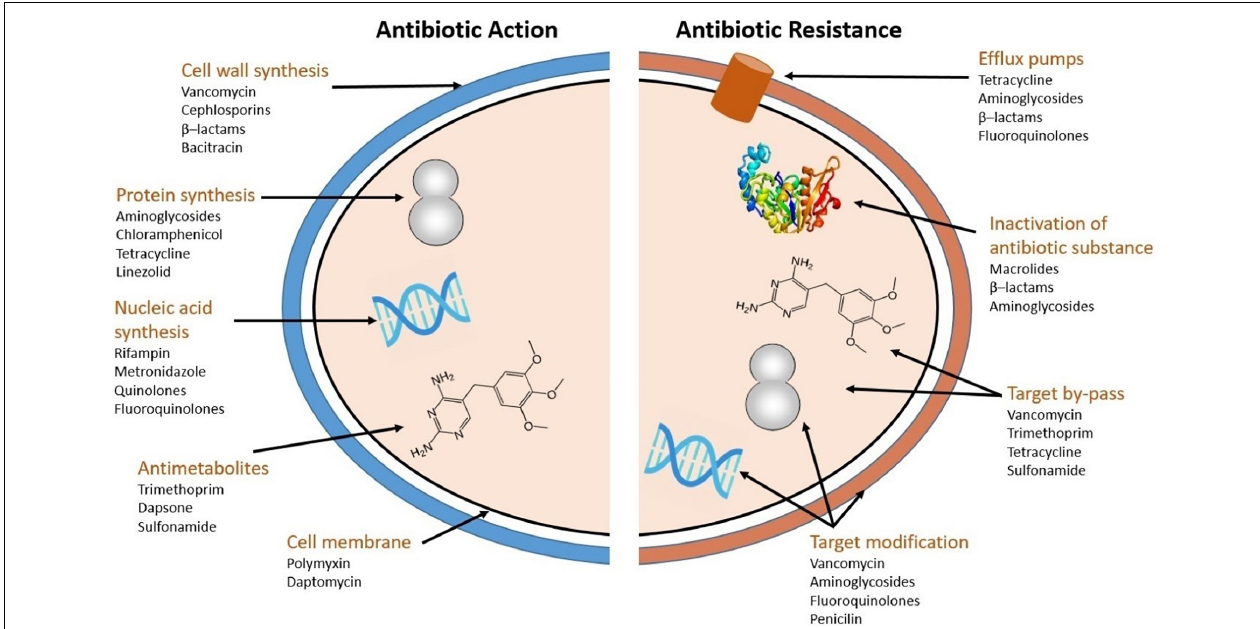
FIGURE 1 | Antibiotic action and resistance mechanisms (adapted from Wright,